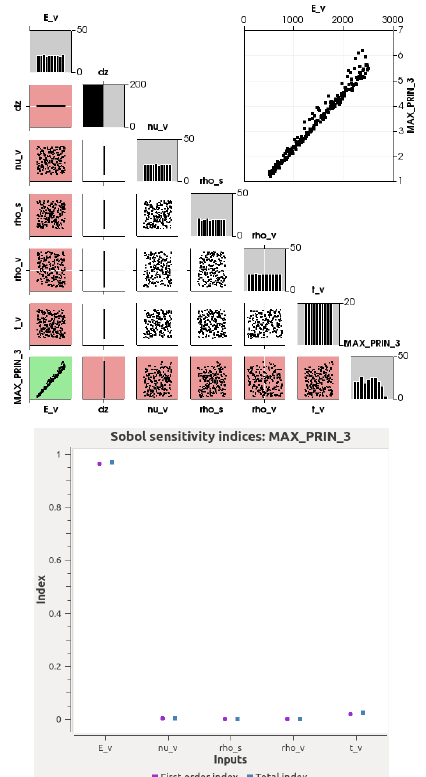
Figure 12. 200 LHS simulations for the top layer maximum principal stress (the sensitivity, calculated with the Sobol indices, is reported below). Figure 14. Analysis performed with the vertical displacement imposed on the central column on the 2D idealized geometry model: distribution of maximum principal stresses before cracking (Up) and the damage pattern (Down).